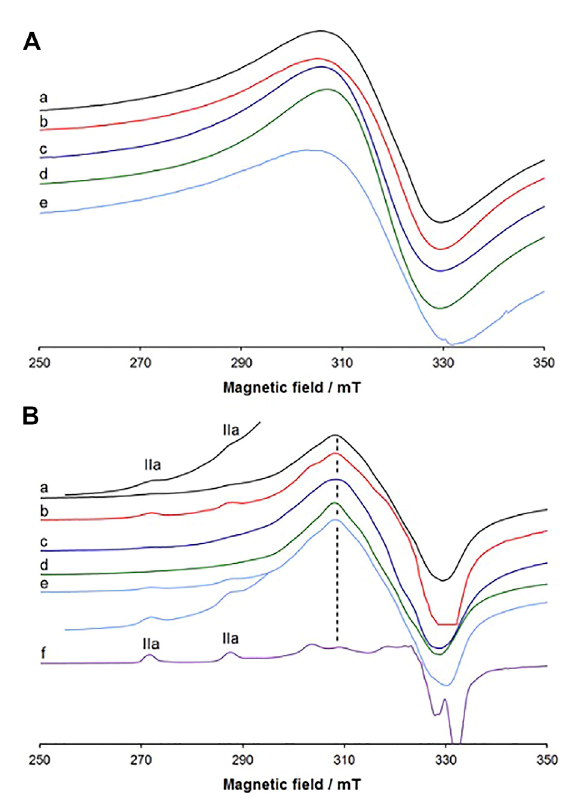
FIGURE 2 (A) X-band EPR spectra recorded at 120 K on: (A) polycrystalline samples of 1 (a), crystalline 5 (b), polycrystalline 5 (c), 6 (d) and 7 (e); (B) polycrystalline samples of 1 (a), 4 (b), polycrystalline 5 (c), crystalline 5 (d), and 6 (e) dissolved in DMSO. The region between 255.0 and 295.0 mT of the traces (a) and (e) is ampli fi ed by four and three times, respectively. In (f) the spectrum recorded in the system Cu(II)/H 2 L 4 1:1 at pH6.50inthemixtureof80%(v/v)DMSO/H 2 Oisalsoshown. IIa indicates the fi rsttwoparallelresonancesofthecomplex[Cu(L)]with[(O − ,N, N 2 im ); DMSO]bindingset,andthedashedlineindicatesthedistinctiveresonance of the trinuclear species [Cu(L)] 3 .